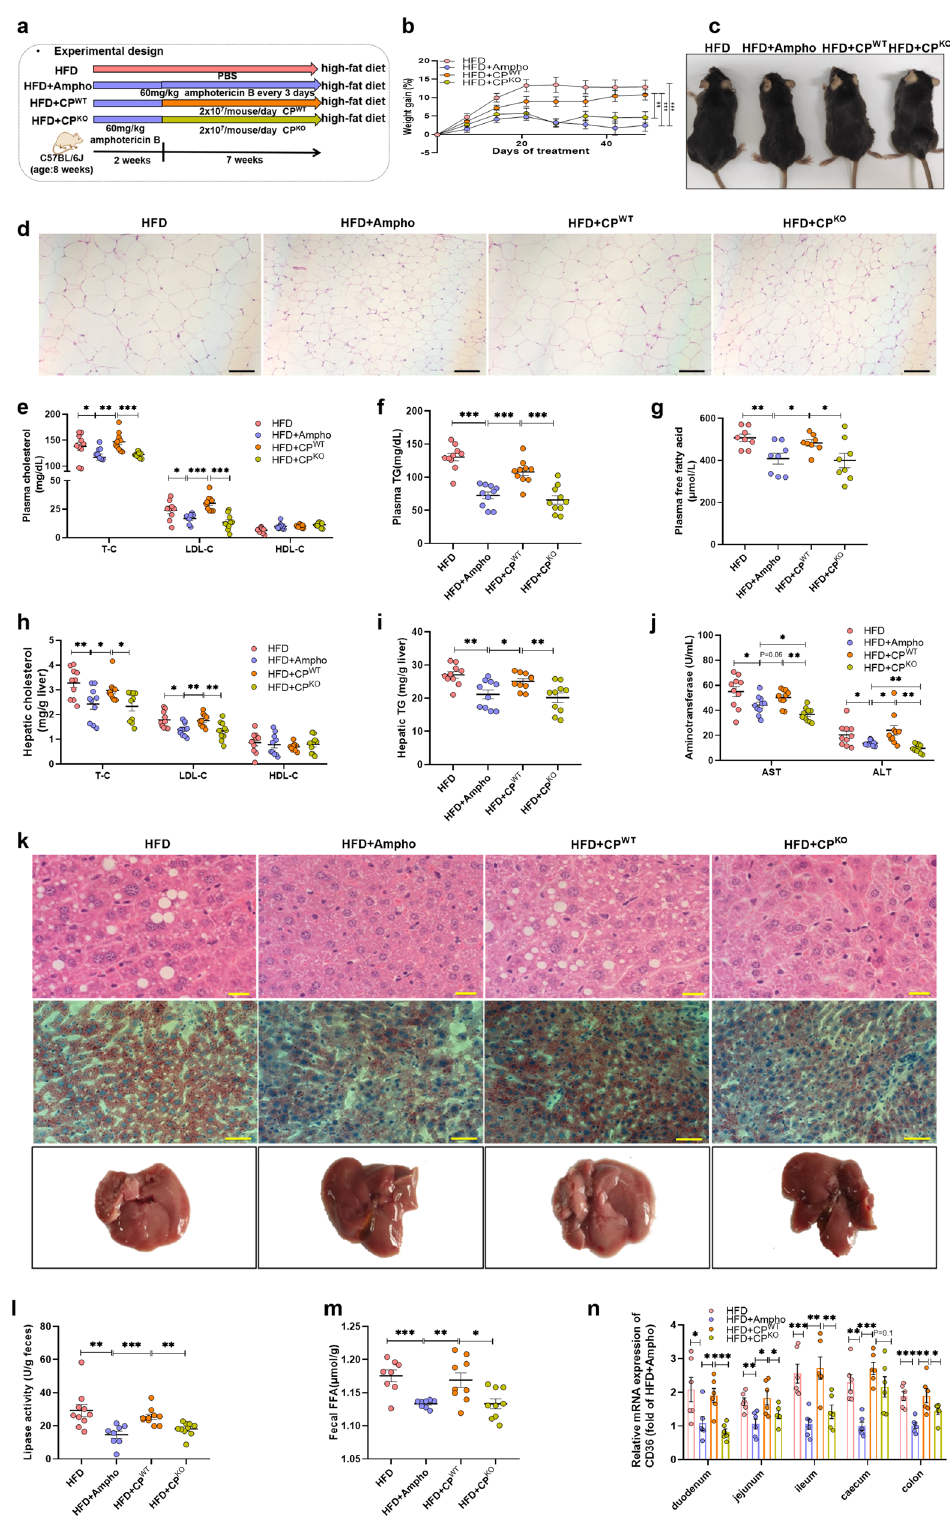
HFD-fed mice given with the lipase mutant strain of C. parasilosis were much lower than that of the HFD-fed mice and the fungi- free HFD-fed mice inoculated with the wild type C. parasilosis (Fig. 5n). The colonization of C. parasilosis together with the following increased CD36 in the gut strongly supported the contribution of gut fungi-derived lipases for the absorption of diet-derived fatty acids in the small